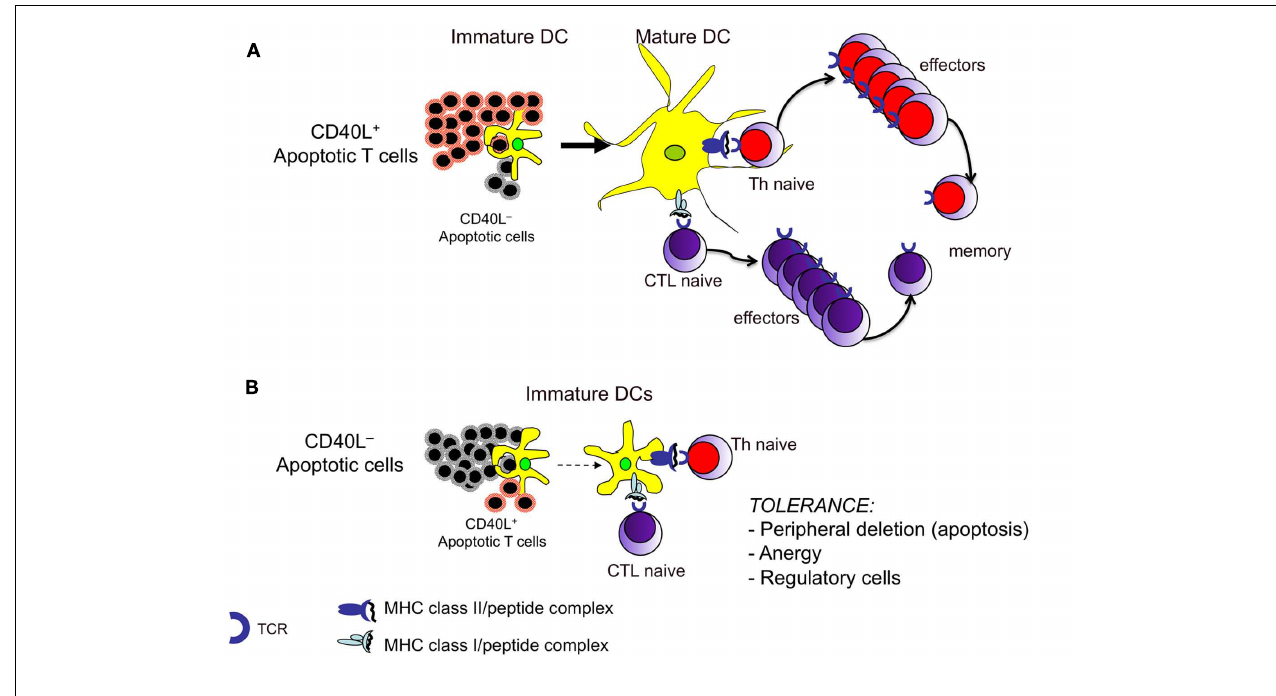
CD40L + apoptoticT cells are overwhelmed by the CD40L − apoptotic cells (i.e., under normal conditions or when an inflammatory process is terminated), the latter will be unable to provide the appropriate signals to DCs, which will deliver tolerance signals to autoreactiveT cells, even though they carry apoptotic cell-derived